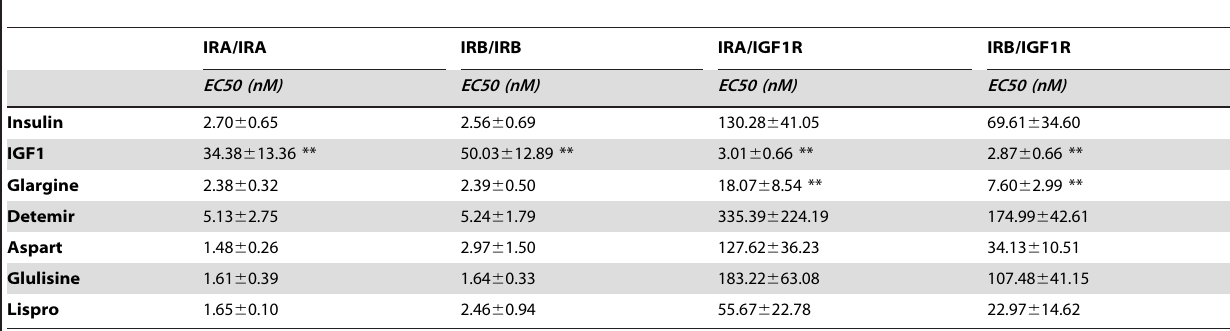
Table 1. EC50s of insulin, insulin analogues and IGF1 towards IR homodimers and IR/IGF1R